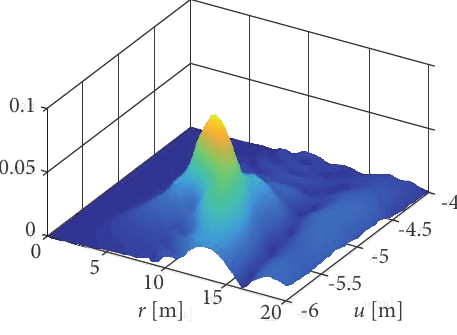
Figure 16. Nearest target PSF obtained via